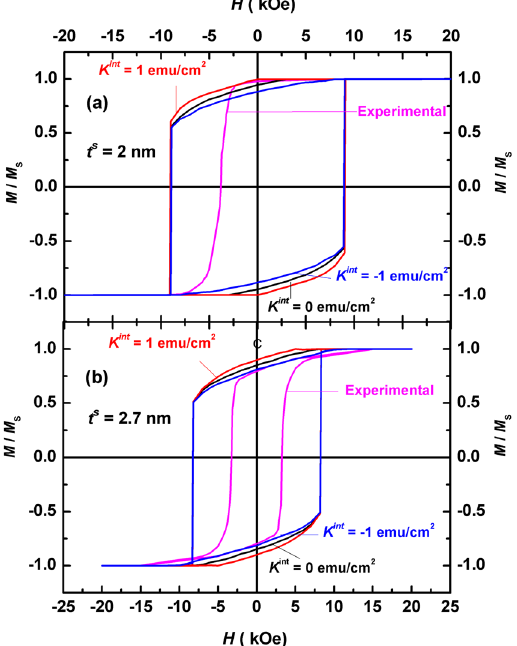
Figure 8. Comparison of calculated and experimental hysteresis loops of FePt (10 nm)/ α -Fe ( t s ) multilayers. ( a ) Loops for soft layer thickness t s = 2 nm, where the experimental hysteresis loop agrees well with that calculated for K int = 1 erg/cm 2 . ( b ) Loops for t s = 2.7 nm, where the experimental loop agrees well with that calculated for K int = − 1 erg/cm 2